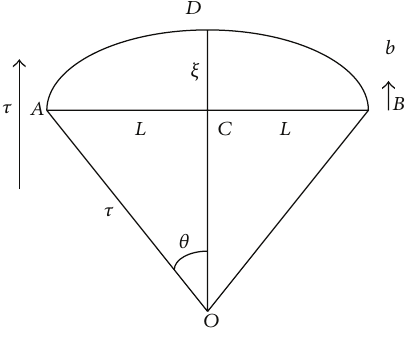
Figure 1: Dislocation monopole